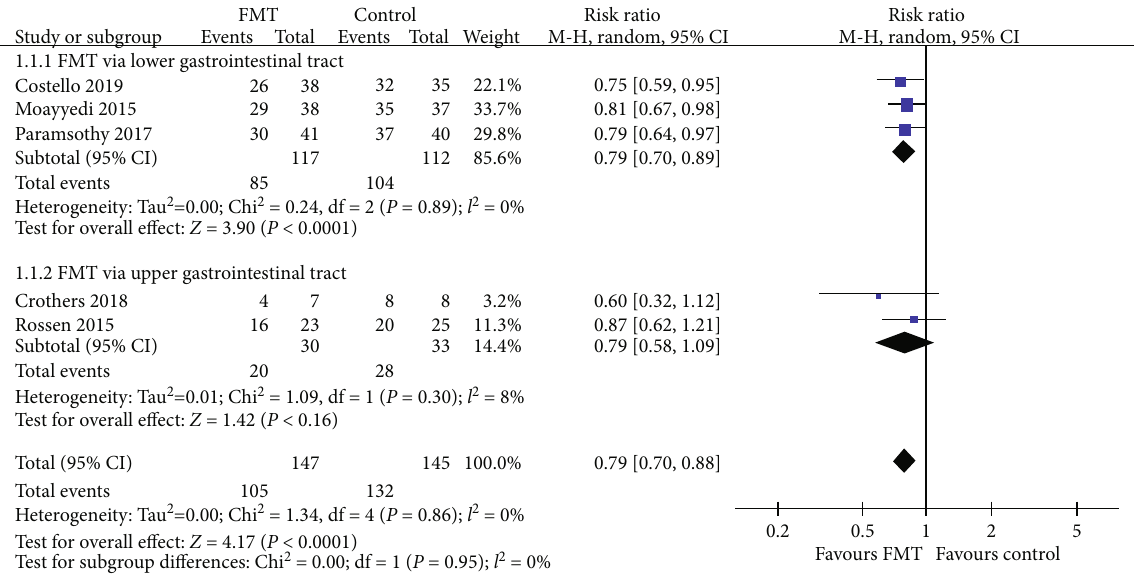
Figure 3: Forest plot of studies reporting combined clinical remission with endoscopic remission/response and subgroup analysis according to di ff erent delivery routes.